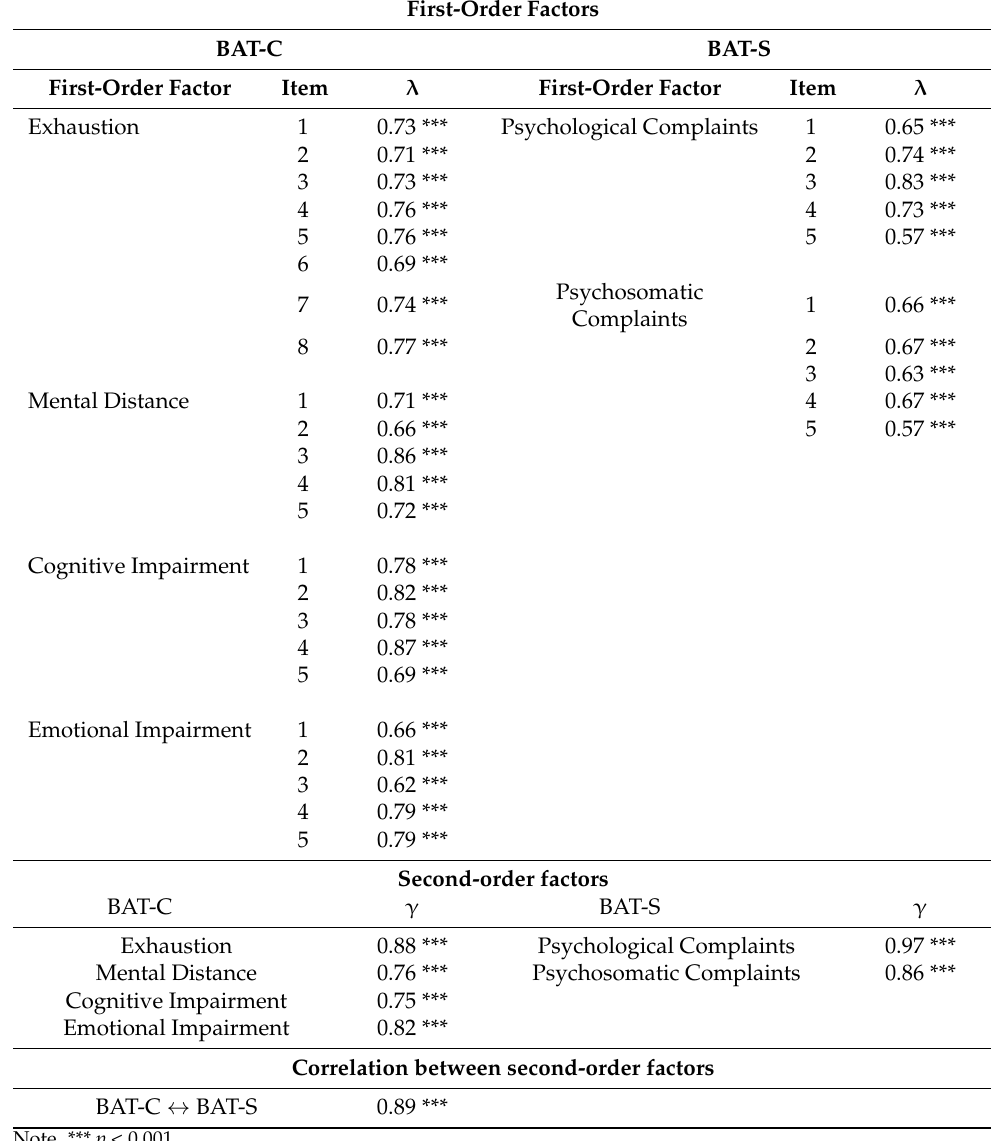
Table 5. Factor loadings of M1 with six first-order factors and two second-order factors ( n =